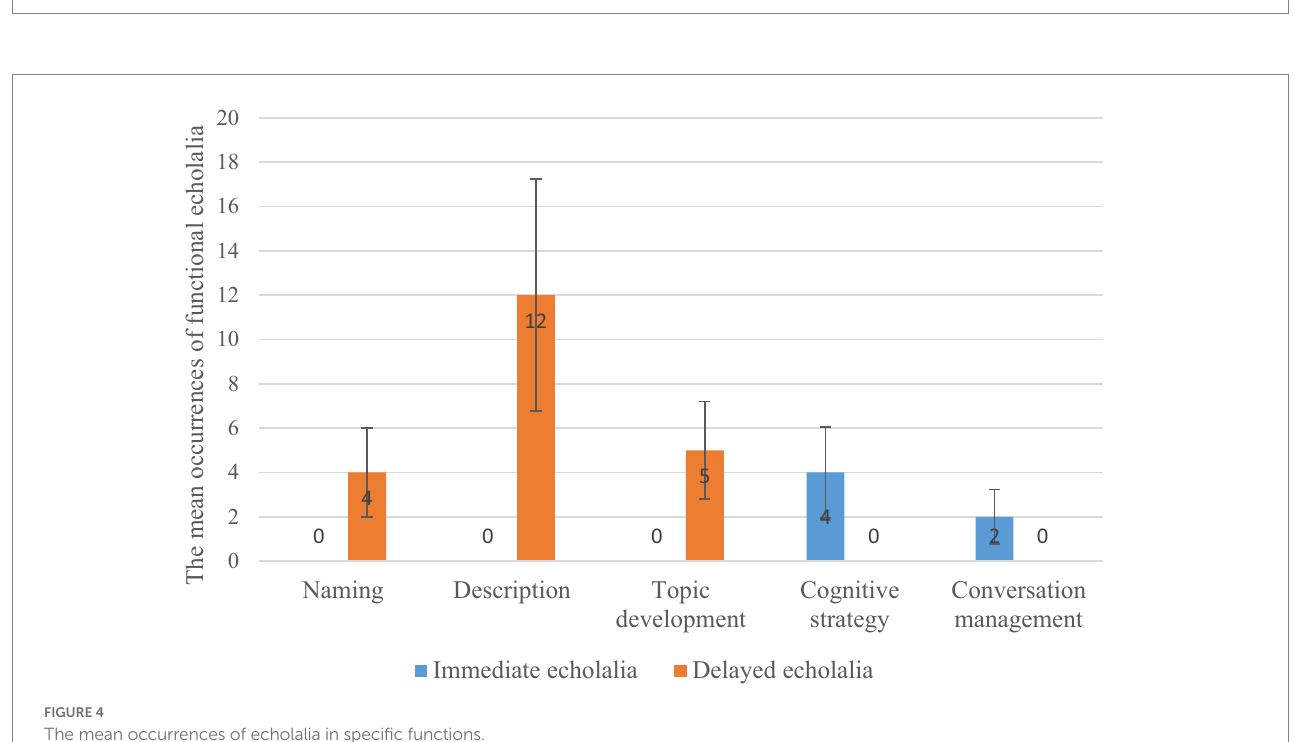
FIGURE 3 The percentages of total occurrences of echolalia in specific functions.